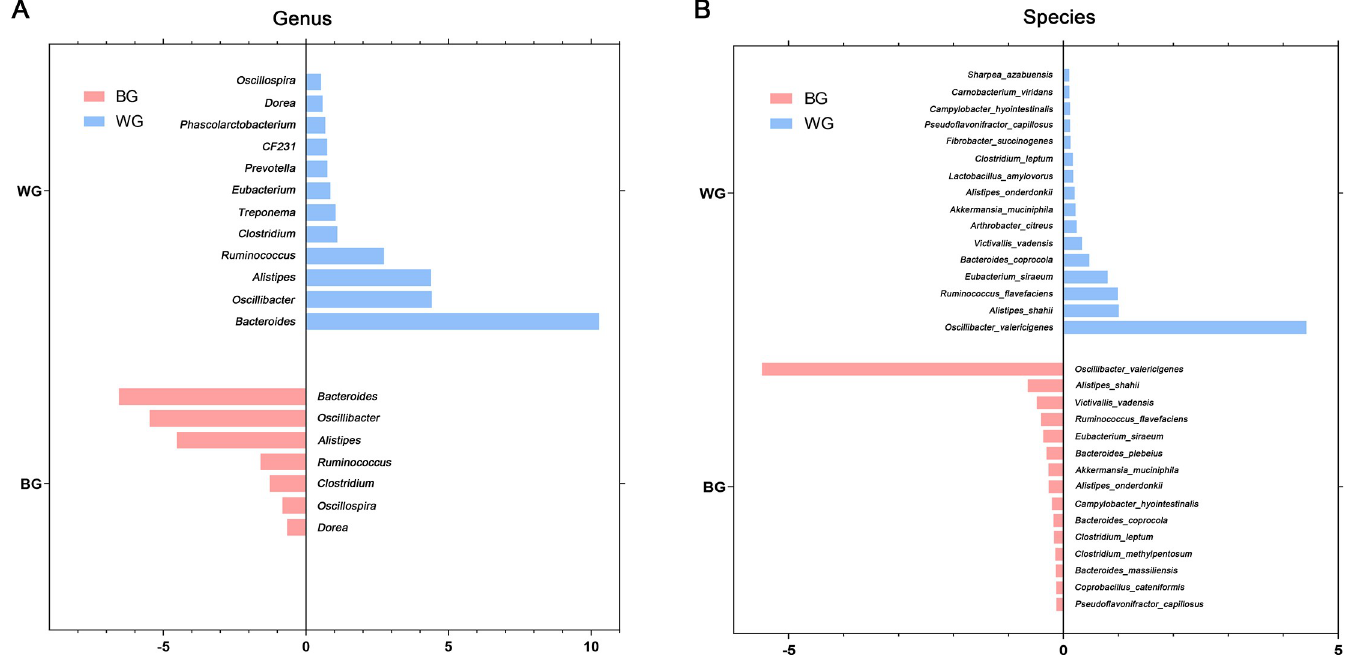
Fig 3. Composition of core gut microbiota of BG and WG at the genus (A) and species (B) level.